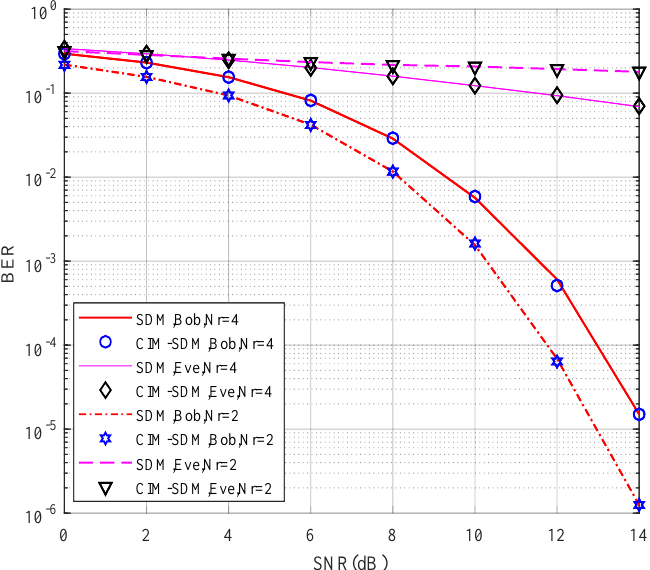
Figure 10. Bob’s and Eve’s constellation error rate performances for the proposed CIM-SDM scheme in comparison to the traditional SDM counterparts.